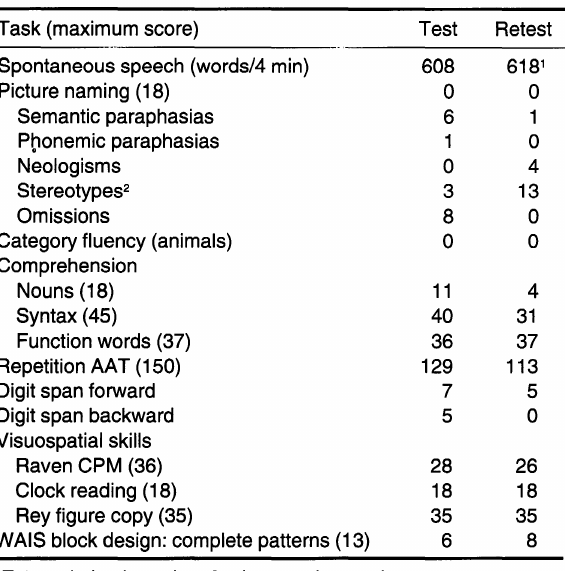
TABLE I. Summary of performances on language and other cogni tive tasks on two occasions, 18 months apart, showing severe defi cits of naming and comprehension (except for syntax and function words), mildly impaired repetition, but normal digit span, and